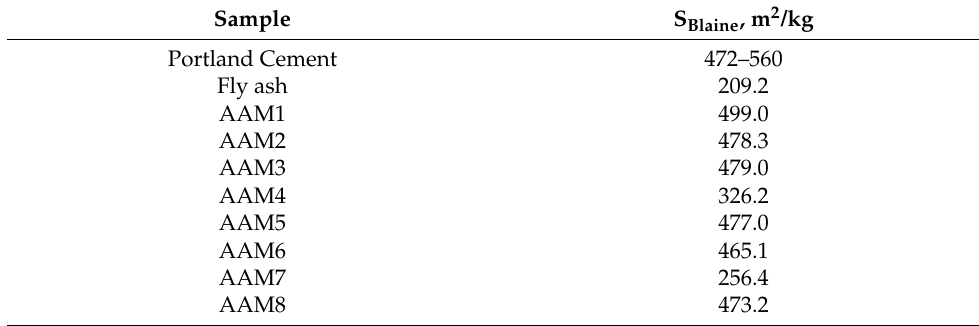
Table 2. The Blaine specific surface area for synthesized